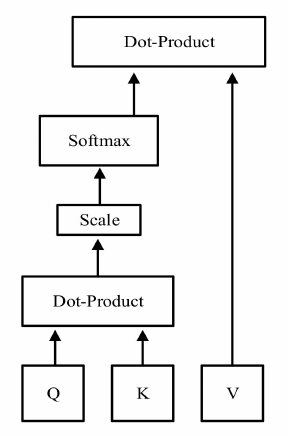
Figure 2. The scaled dot-product